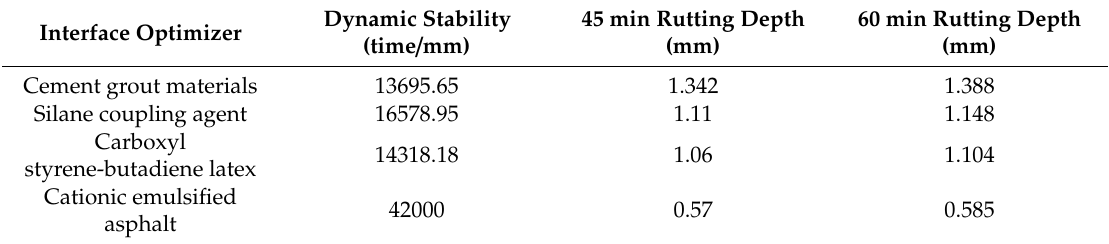
Table 10. Rutting test